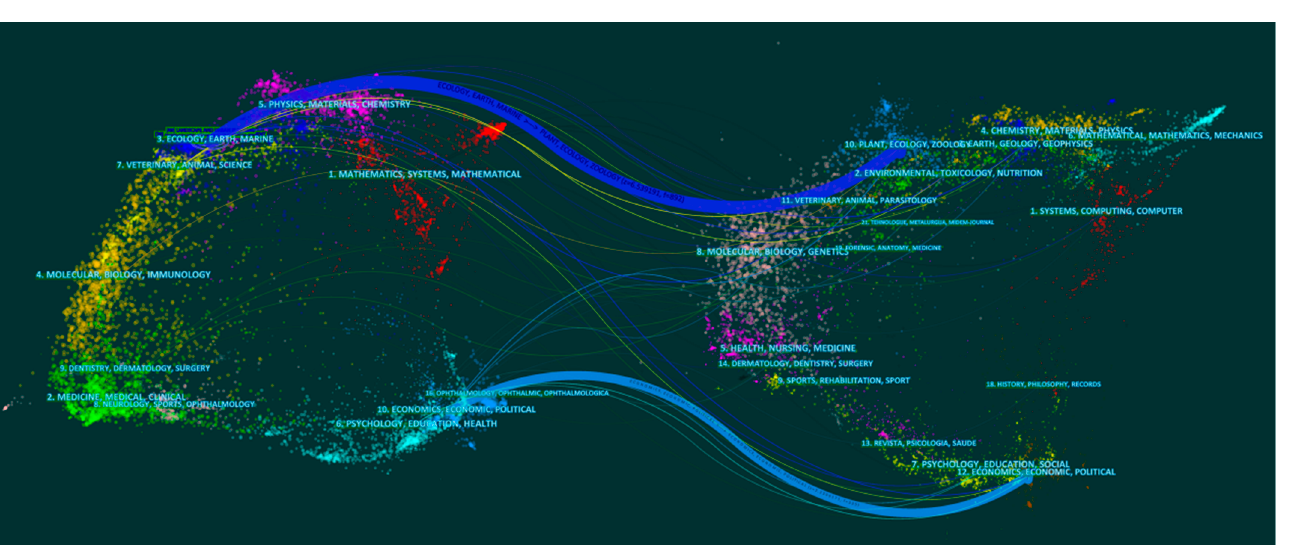
Figure 6. Distribution of the main research disciplines from 1990 to 2021.